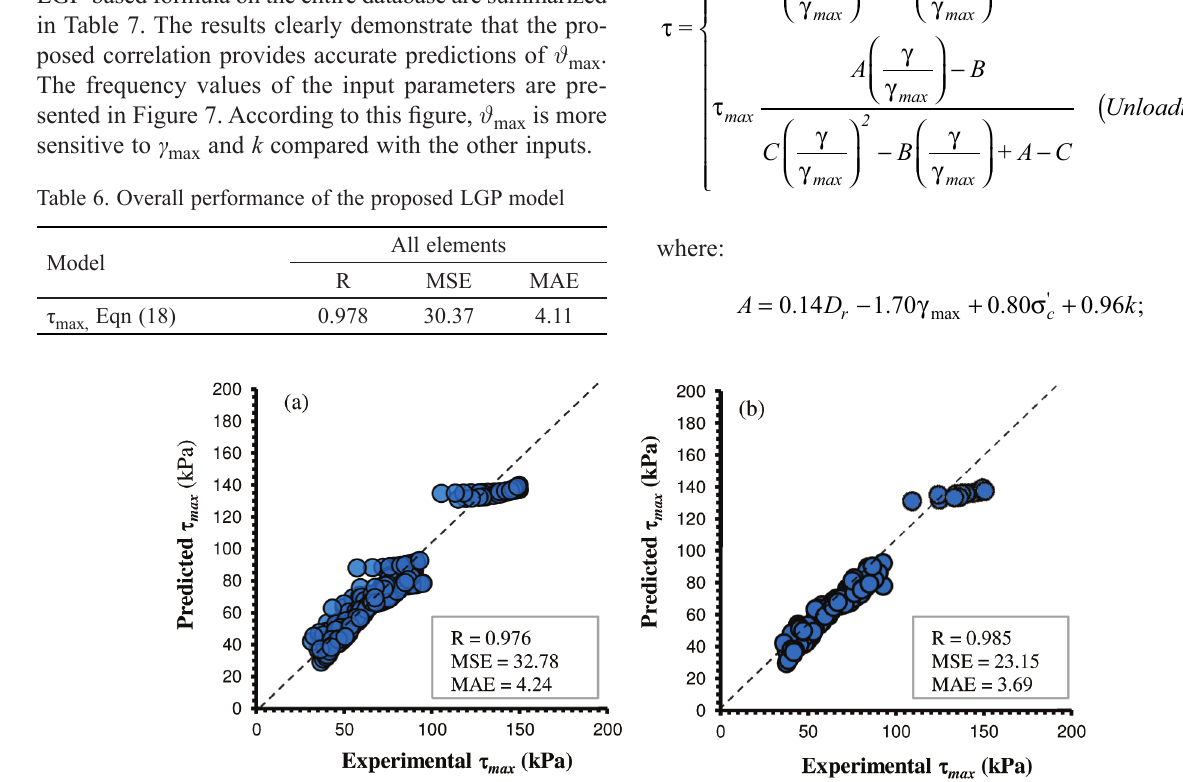
Fig. 6. Experimental versus predicted  max values using the LGP model: a) training data; b) testing data